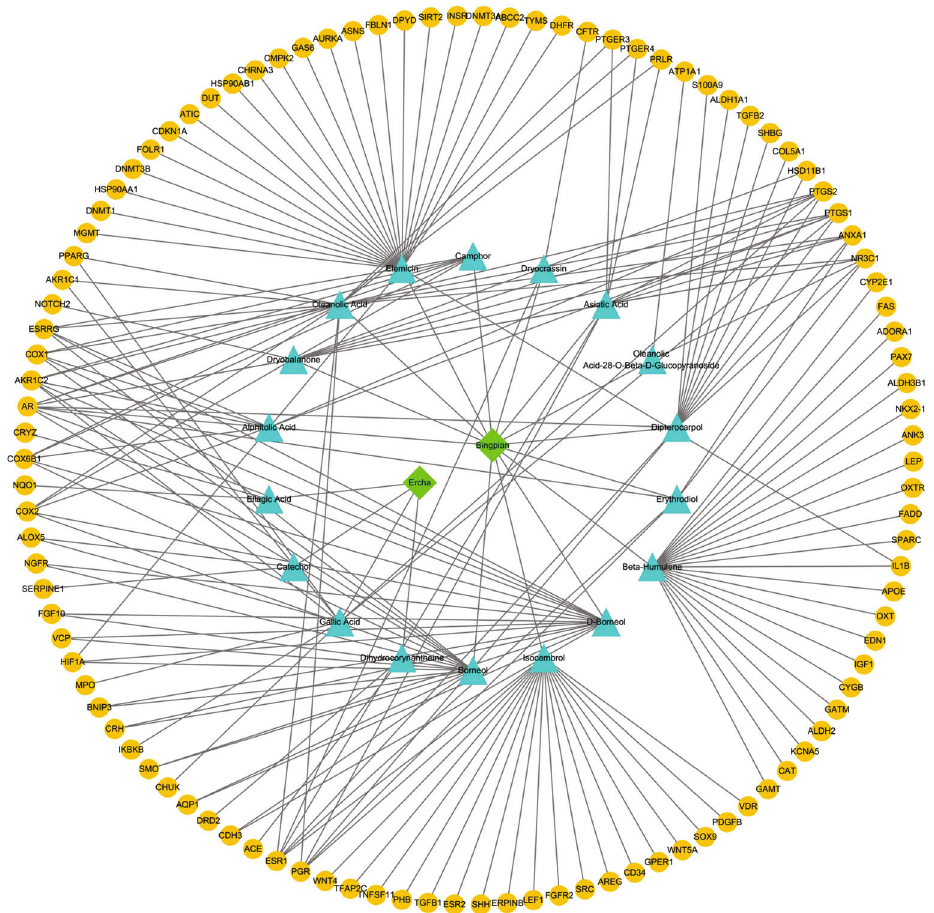
Figure 3: Traditional Chinese medicine compound-ingredients-target network.